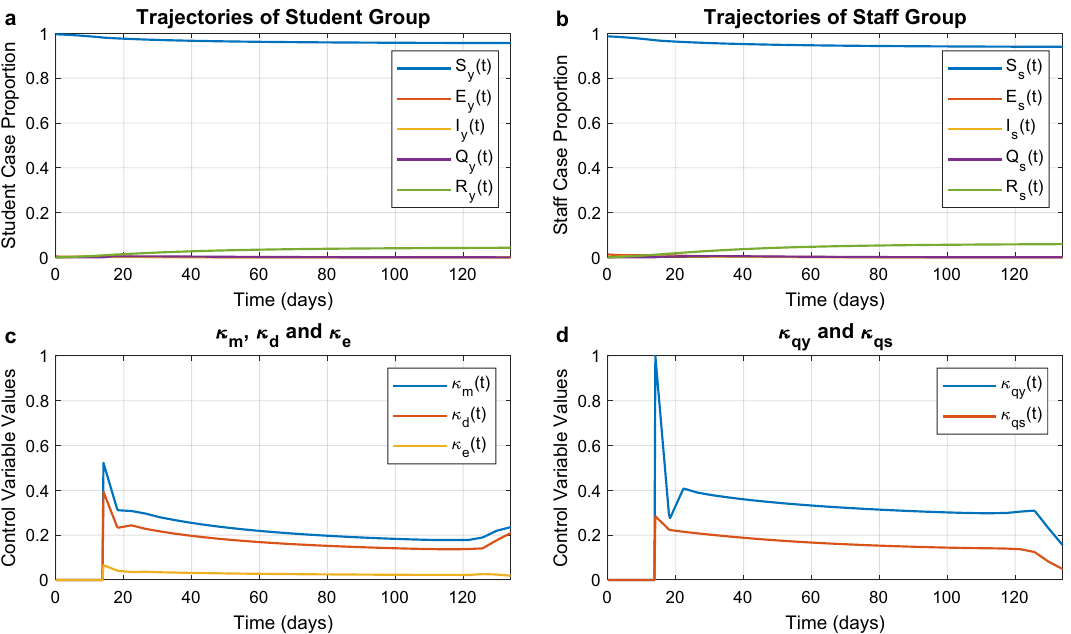
Figure 4. Optimal trajectories for the minimum intervention scenario. Optimal trajectories when the department would like to minimise the enforcement of control measures. ( a ) and ( b ) The epidemic evolution among students and staff, respectively. ( c ) The optimal strategies for mask wearing ( κ m ), social distancing ( κ d ), and environmental disinfection ( κ e ). ( d ) The optimal strategies for mandatory quarantine on infected students ( κ qy ) and infected staff ( κ qs